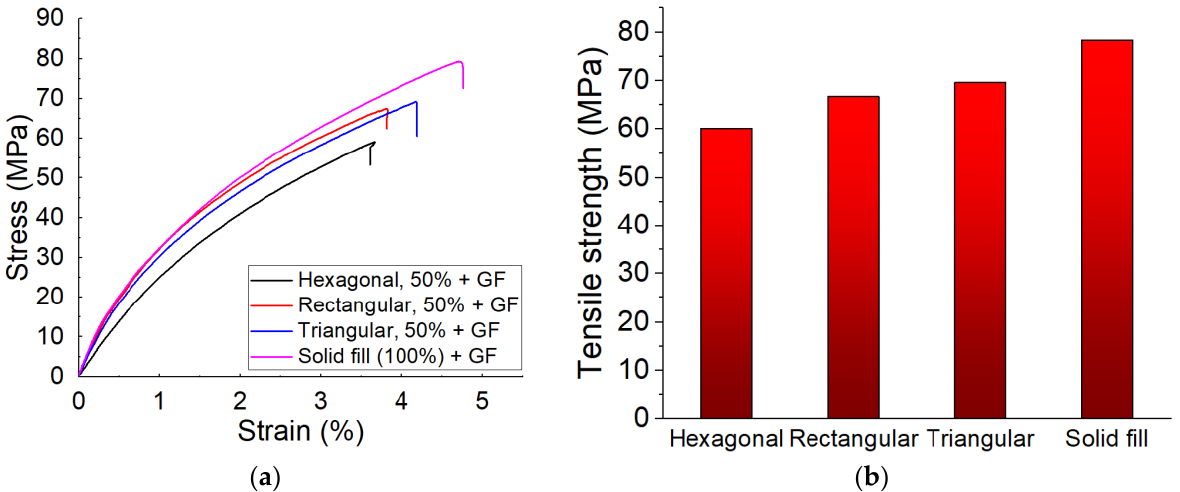
Figure 13. Obtained tensile test curves ( a ) and obtained strength ( b ) of CF-PA6 reinforced with continuous glass fiber specimens [24].